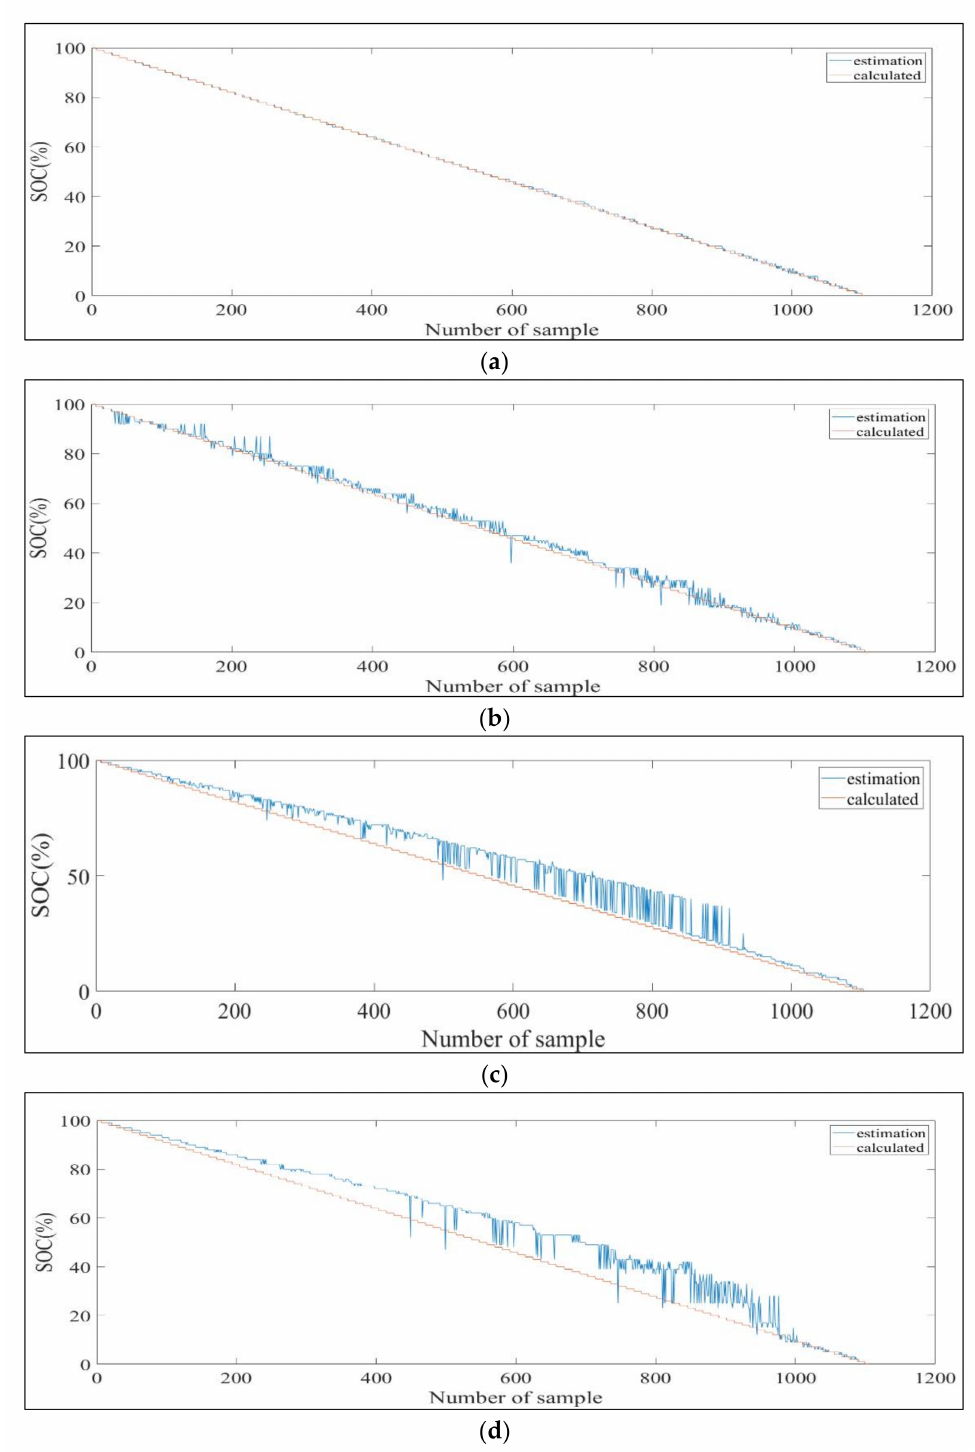
Figure 13. The SOC estimation result of pattern 6 when there were two input voltage parameters: ( a ); the proposed method using the LSTM result ( b ); the proposed method using the MNN result ( c ); only LSTM result ( d ); only MNN